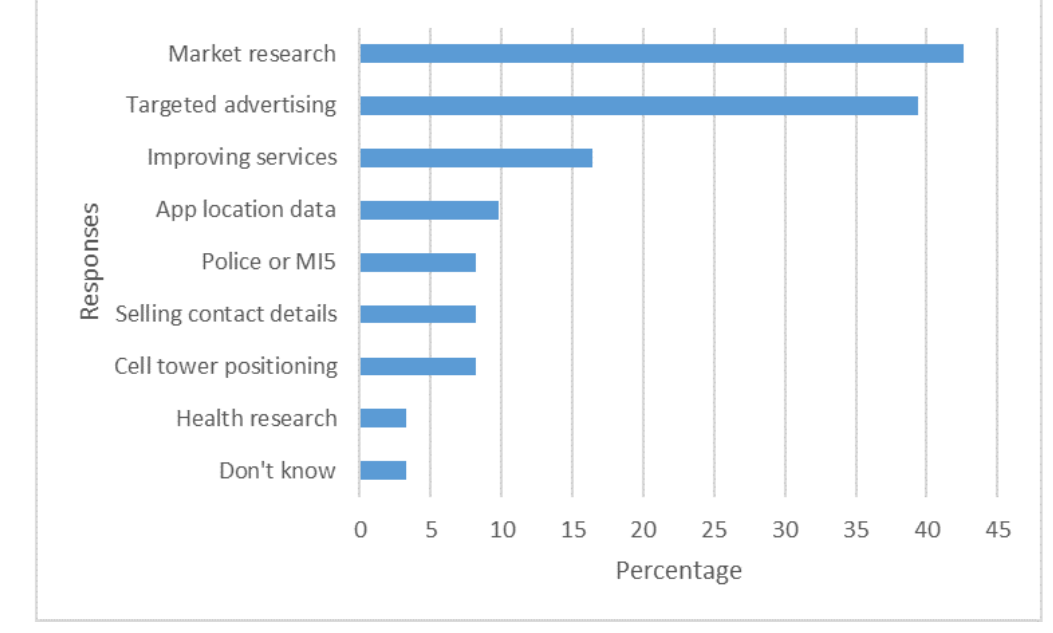
Figure 2. Public responses on how mobile phone data are being used.